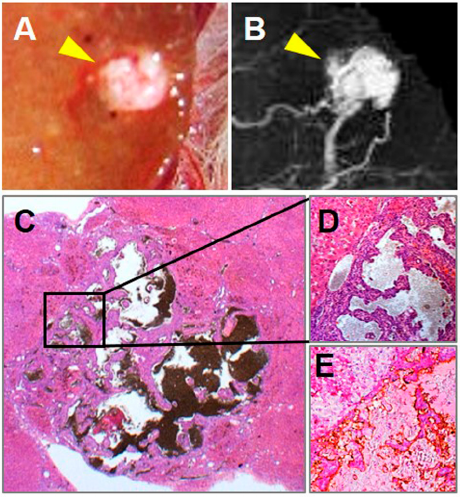
Figure 2. Pathological specimen, microangiographic and microscopic results of a representative angioma-like HCC. Macrographic ( A ) and ( B ) microangiographic views of a tumor-bearing liver lobe revealed a hyper-vascularized lesion (arrowhead) perfused by barium sulfate suspension. Microscopically with H&E staining, the angioma-like HCC was classified as an undifferentiated cancer type ( C , original magnification × 12.5, scale bar = 800 µ m), filled with enlarged intratumoral vascular lakes, and capsuled or circumscribed by fibrous, on liver cirrhosis background ( D . Original magnification × 100, scale bar = 100 µ m). CD34-PAS dual staining indicated that tumor blood pools were lined by positively stained endothelia ( E . original magnification × 100, scale bar = 100 µ